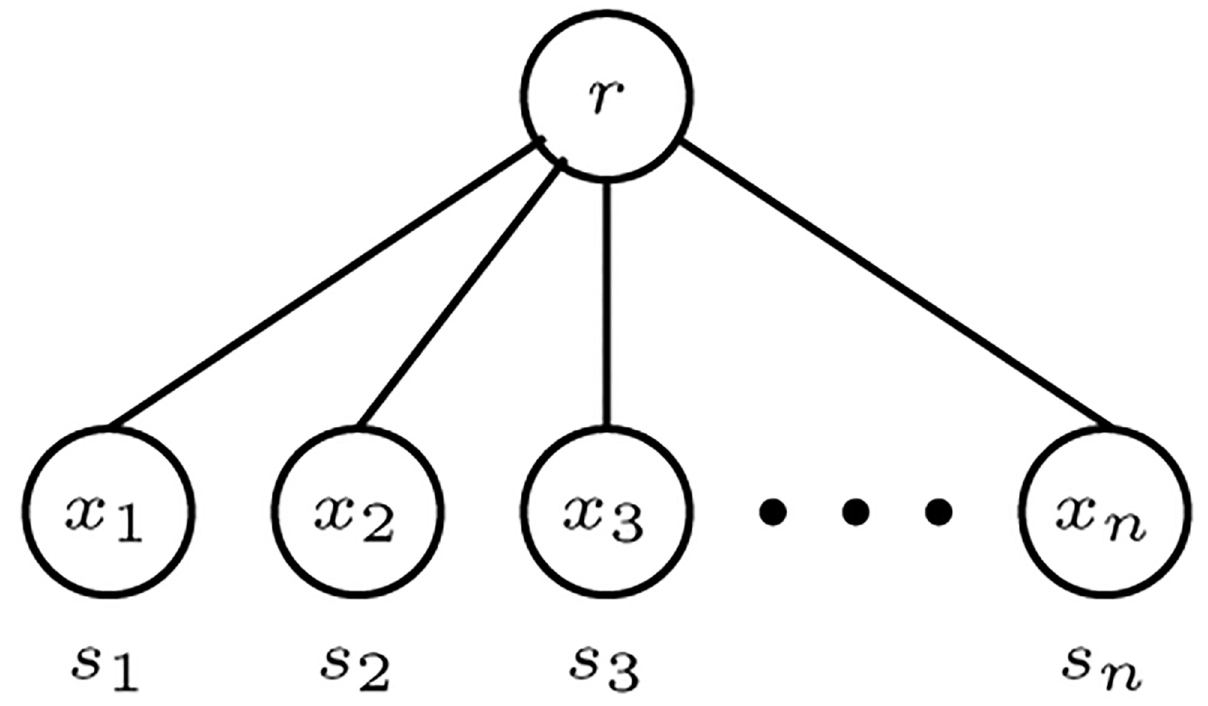
Fig 2. A trivial non-binary S -tree with a minimum number of nodes and no evolutionary assumptions [3].